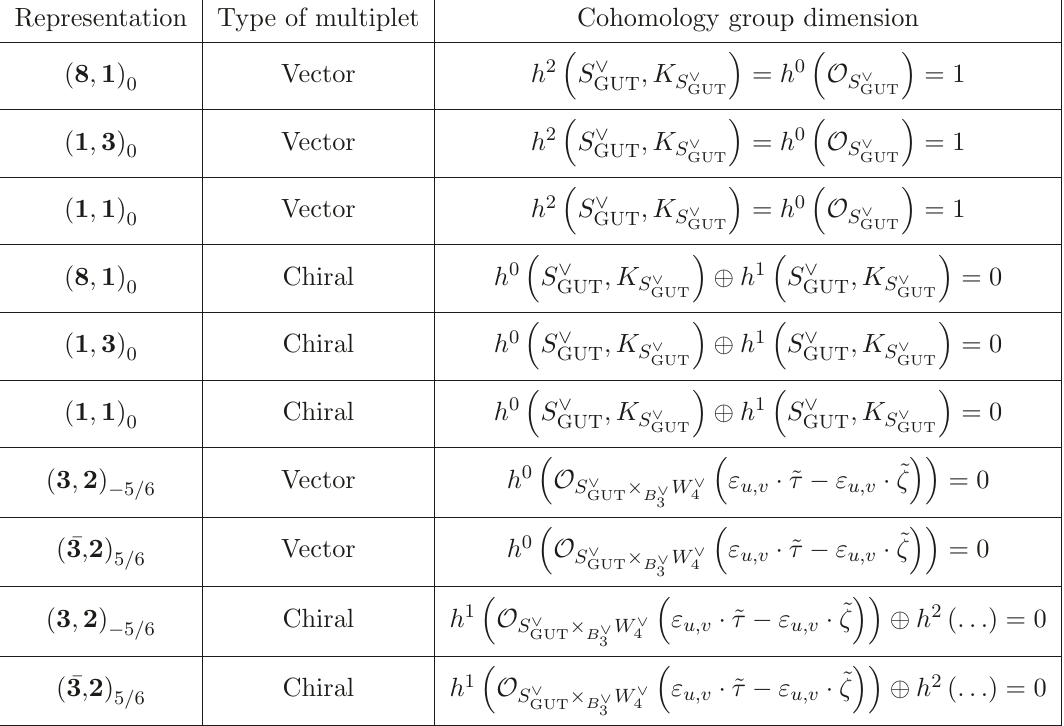
Representation Type of multiplet Cohomology group